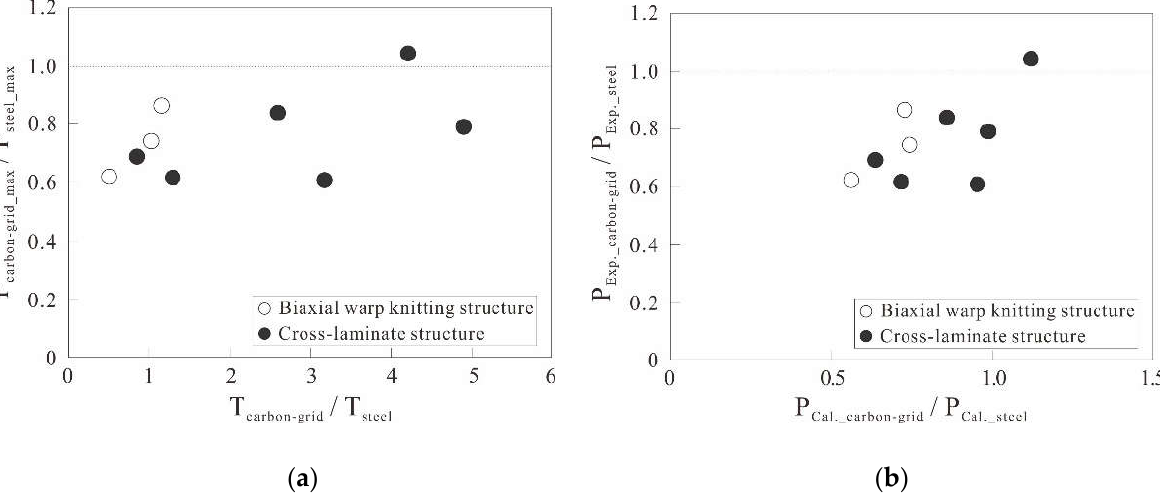
3 Figure 18. Comparison of the maximum load between the specimens reinforced with carbon grids